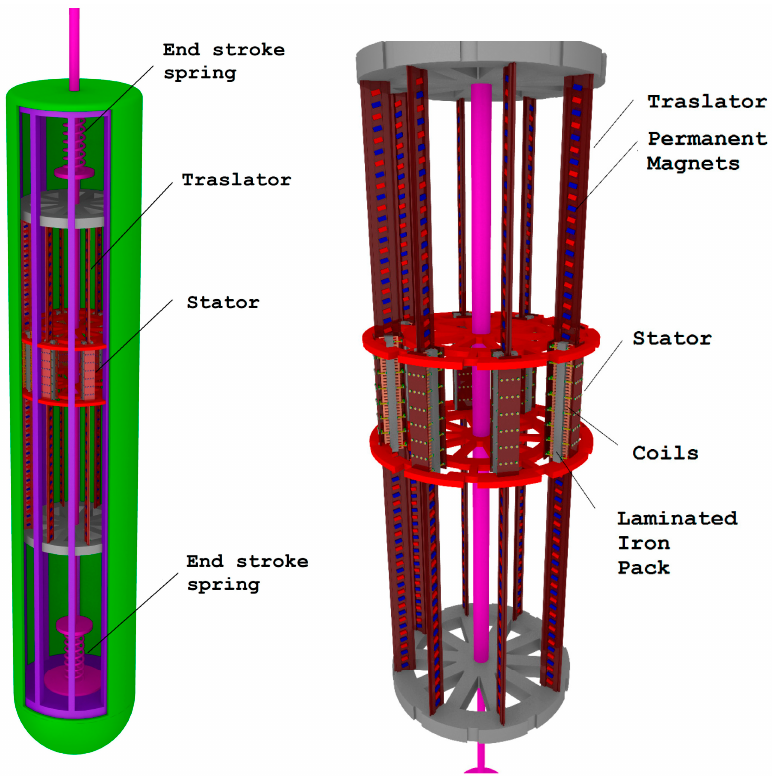
Figure 13. Cross section and internal view of the inner buoy of the DEIM Point Absorber.